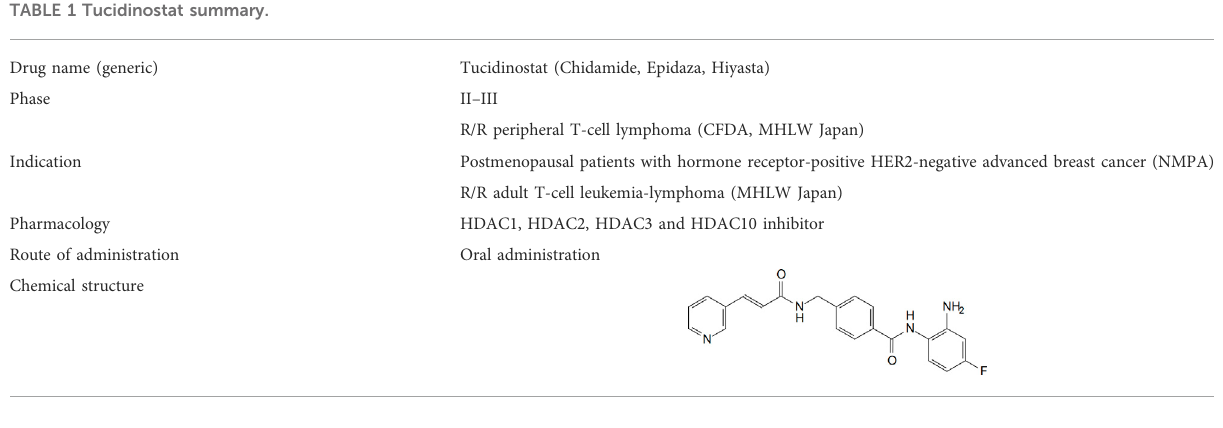
TABLE 1 Tucidinostat